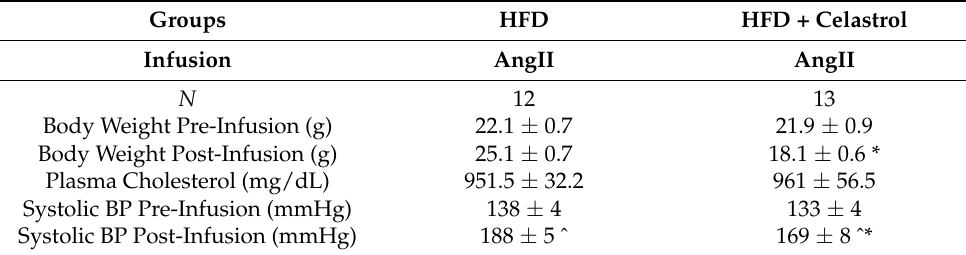
Table 1. Effects of Celastrol in male Ldl receptor -/- mice infused with high dose of AngII (1000